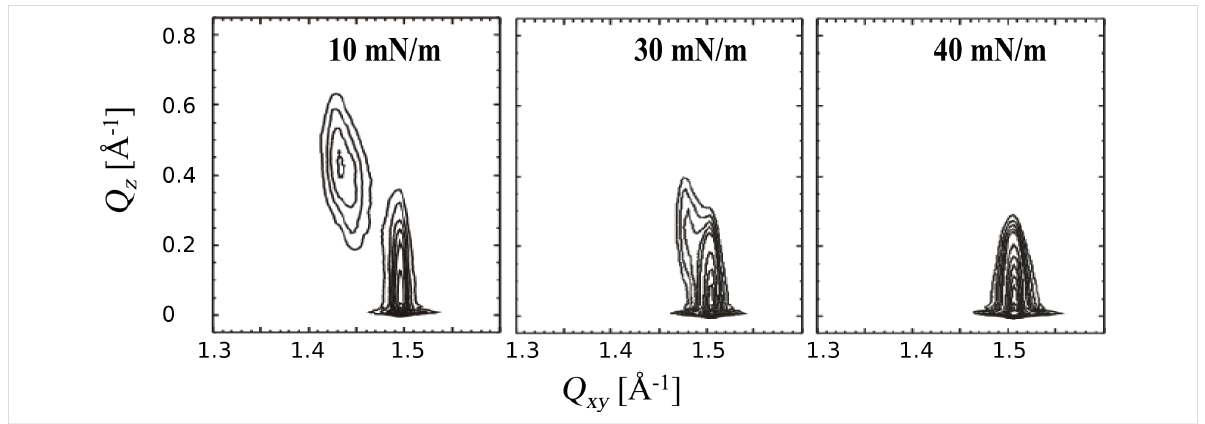
Figure 6: Contour plots of the corrected X-ray intensities plotted versus the in-plane ( Q xy ) and out-of-plane ( Q z ) components of the scattering vector for C1P monolayers on the pH 4 subphase with calcium (citric buffer with 1 mM Ca 2+ and 150 mM NaCl) at 10 mN/m (left), 30 mN/m (middle) and 40 mN/m (right).